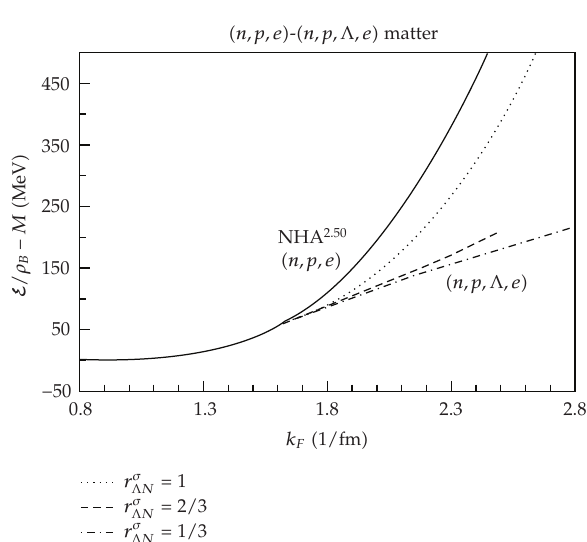
Figure 2: The binding energies of (cid:7) n,p,e (cid:8) and (cid:7) n,p, Λ ,e (cid:8) . The onset density of Λ is about k F (cid:5) 1 . 7fm − 1 as shown in the figure. The ratios of Λ -coupling constant on σ are (cid:7) dotted line (cid:8) r σ Λ (cid:7) dashed line (cid:8) r σ (cid:5) 2 / 3, (cid:7) dotted-dashed line (cid:8) r σ Λ N fixed as in Table